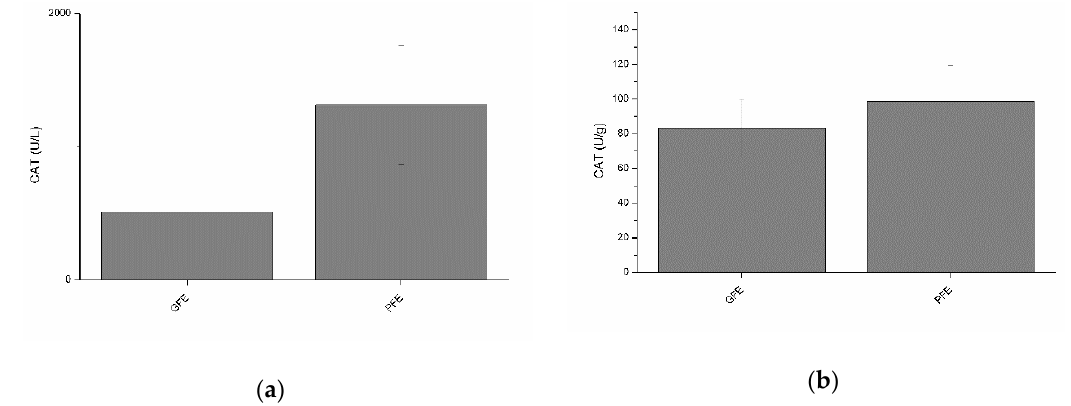
Figure 2. Catalase activities in stallion seminal plasma (mean ± SEM): ( a ) total activity; ( b ) specific activity. No significant ( p > 0.05) differences between good (GFE) and poor freezability ejaculates (PFE) were observed.